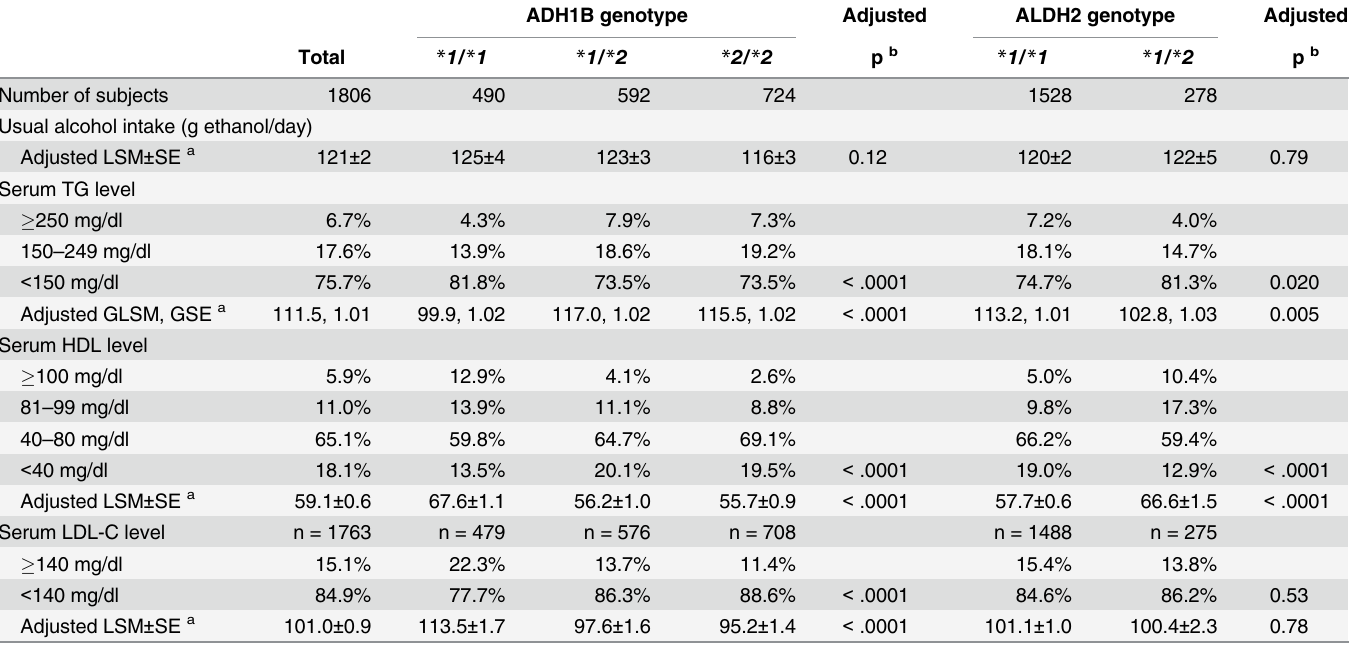
Table 2. Comparisons between the serum lipid levels of Japanese alcoholic men according to their ADH1B and ALDH2 genotypes.